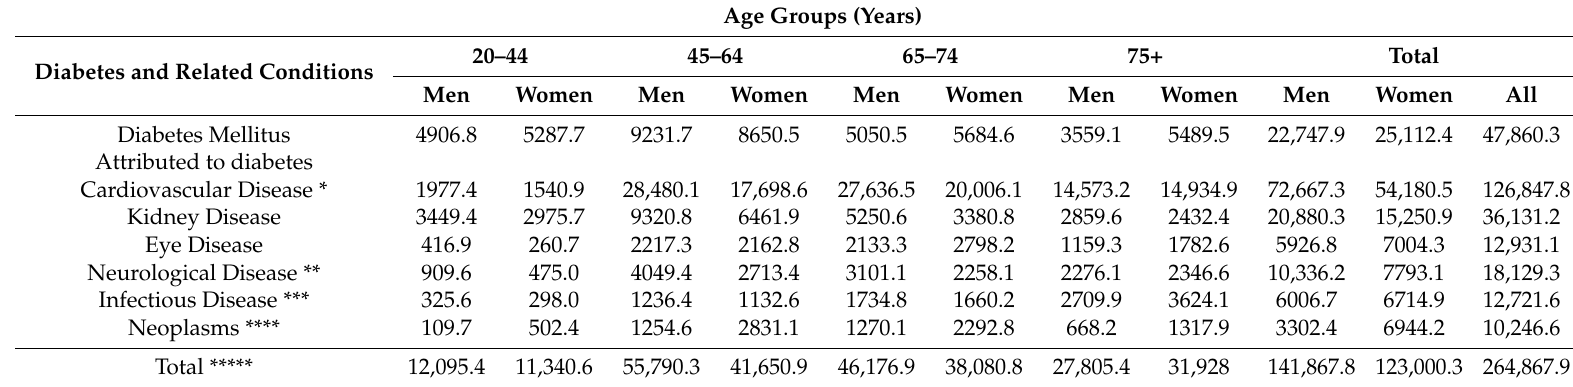
Table 3. Total hospitalization cost (in 000 Int$) due to diabetes and related conditions by age group and sex, SUS, Brazil, 2014.